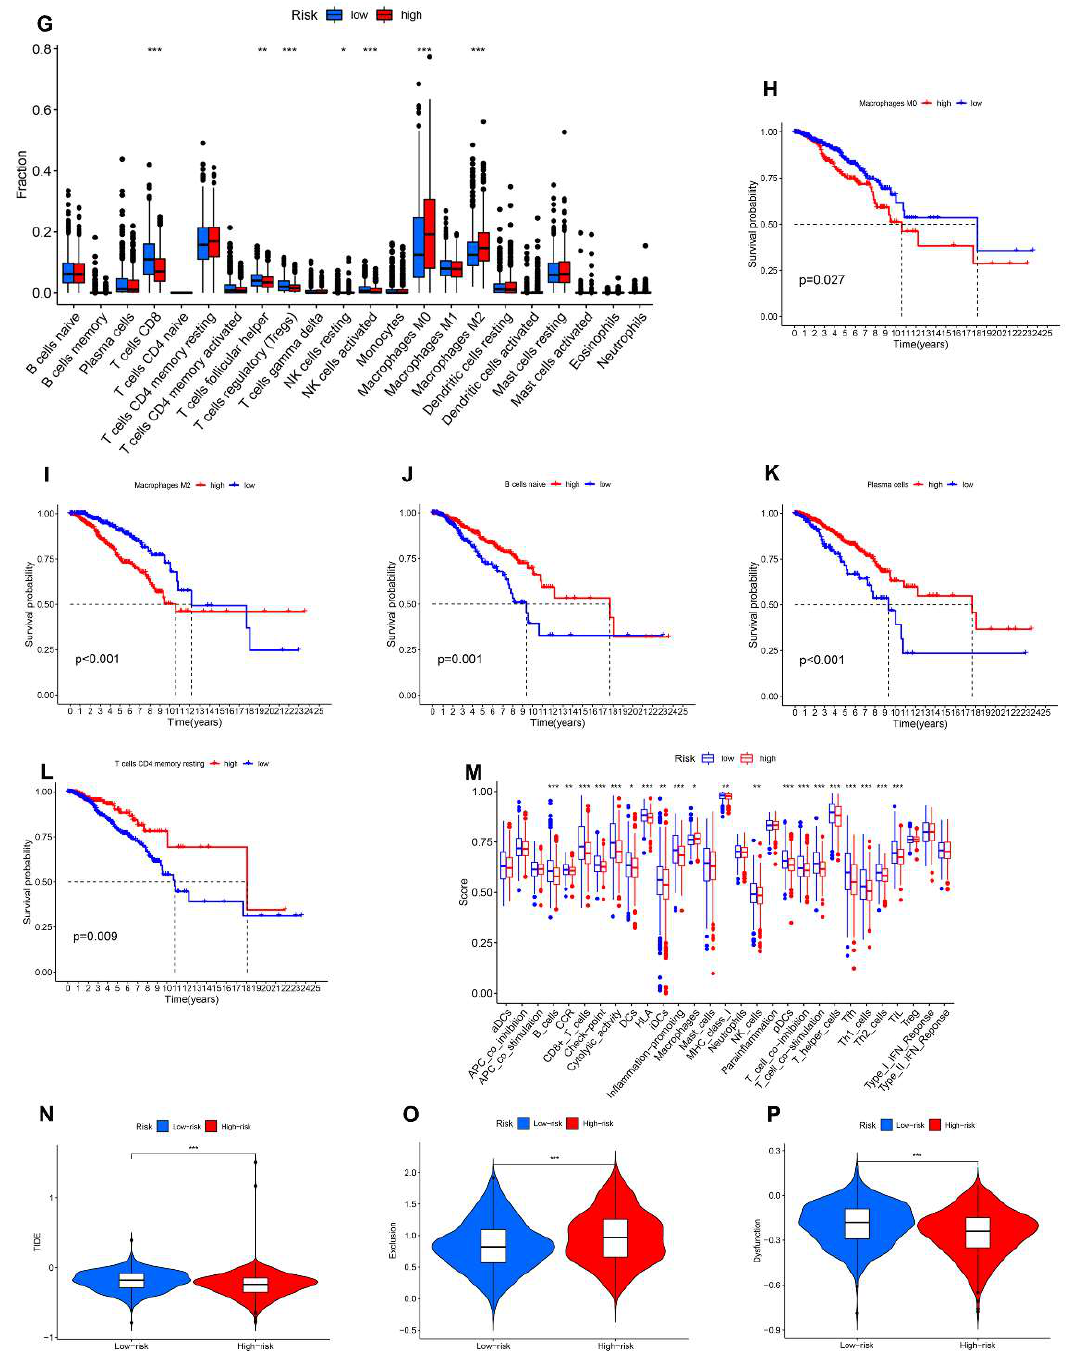
Figure 8. Comprehensive analysis of immune characteristics. ( A – F ) Expression of immune checkpoint members, including PD-L1, PD-1, CTLA-4, LAG3, IDO1, and ICOS, for the high- and low-risk BC groups. ( G ) M0 macrophages and M2 macrophages were elevated, while CD8 T cells, follicular helper T cells, regulatory T cells (Tregs), resting NK cells, and activated NK cells were decreased in the high-risk group compared with the low-risk group ( * p < 0.05, ** p < 0.01, and *** p < 0.001). ( H – L ) Different levels of immune cell infiltration in BC patients reveal differences in prognosis. ( M ) Immune-related effects in the high- and low-risk groups based on ssGSEA. ( N – P ) Violin plot of TIDE scores, TIDE exclusion score, and TIDE dysfunction scores. * p < 0.05, ** p < 0.01, and ** * p < 0.001.